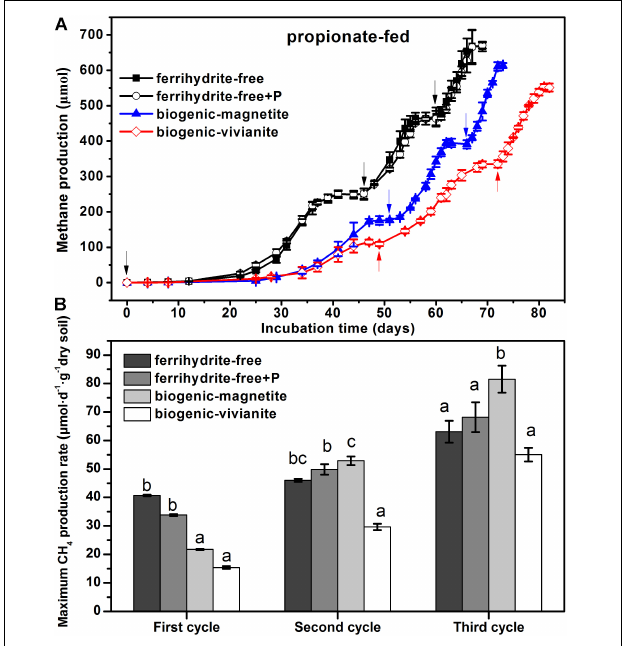
FIGURE 3 | CH 4 yield (A) and CH 4 production rate (B) in the propionate-fed cultures (different letters indicate significant differences among four treatments in a feeding cycle; the arrows denote the addition of